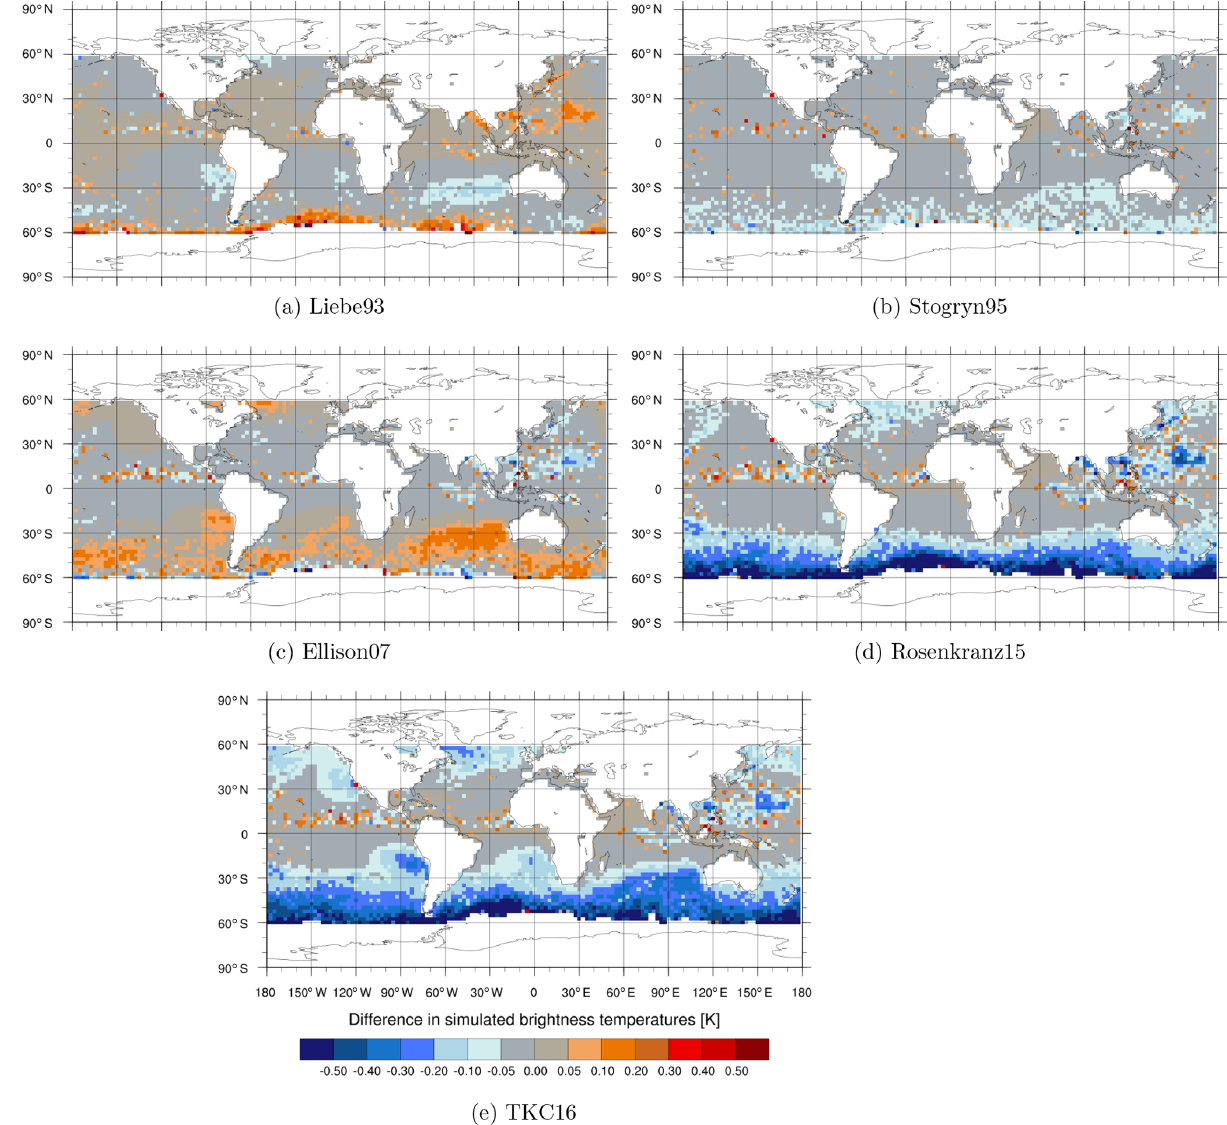
Figure 5. As in Fig. 3 but for channel